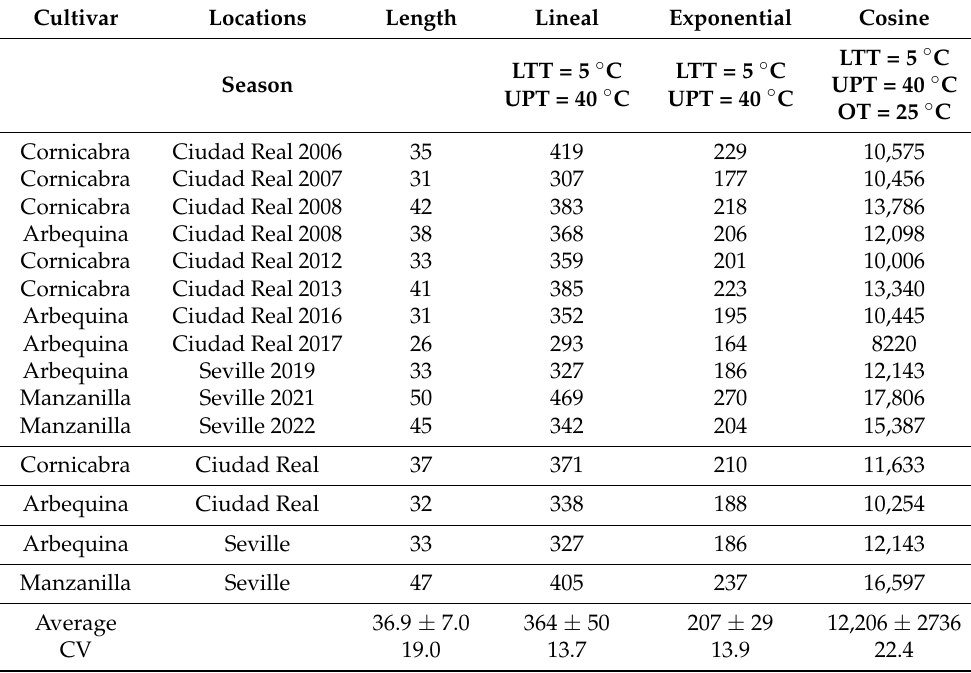
Table 4. Characterization of Period II of pit-hardening period in different cultivars and locations: length (days), and thermal time ( ◦ days) according to three different models (lineal, exponential and